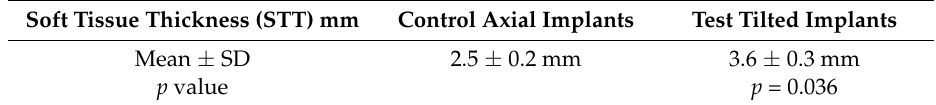
Table 1. Soft tissue thickness (STT) comparison between axial and tilted implants. The group B implants showed more STT when compared to group A implants. Significant difference was p < 0.05.